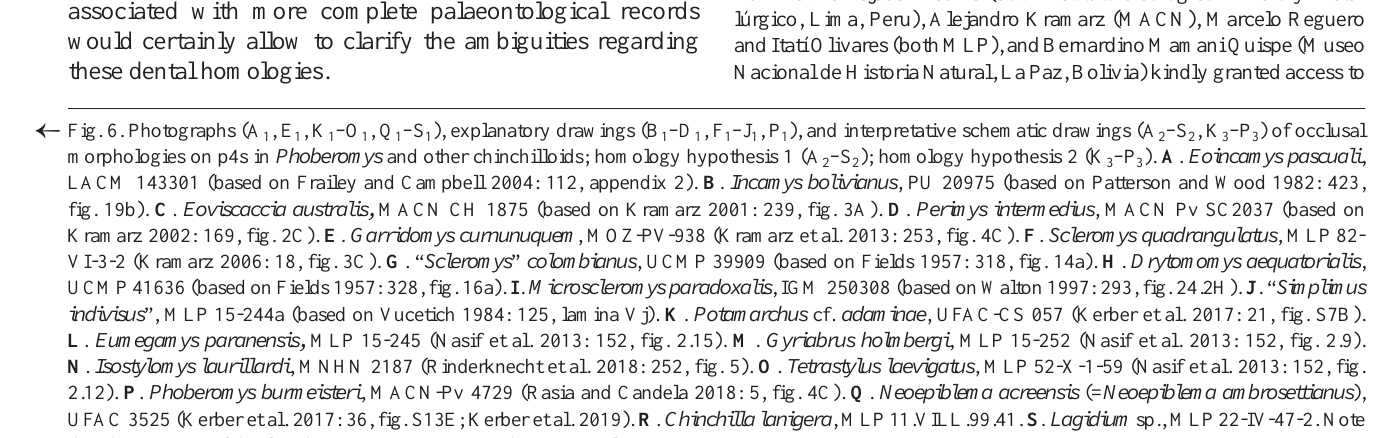
Fig. 6. Photographs (A 1 , E 1 , K 1 –O 1 , Q 1 –S 1 ), explanatory drawings (B 1 –D 1 , F 1 –J 1 , P 1 ), and interpretative schematic drawings (A 2 –S 2 , K 3 –P 3 ) of occlusal morphologies on p4s in Phoberomys and other chinchilloids; homology hypothesis 1 (A fig. 19b). C . Eoviscaccia australis, MACN CH 1875 (based on Kramarz 2001: 239, fig. 3A). D . Perimys intermedius , MACN Pv SC2037 (based